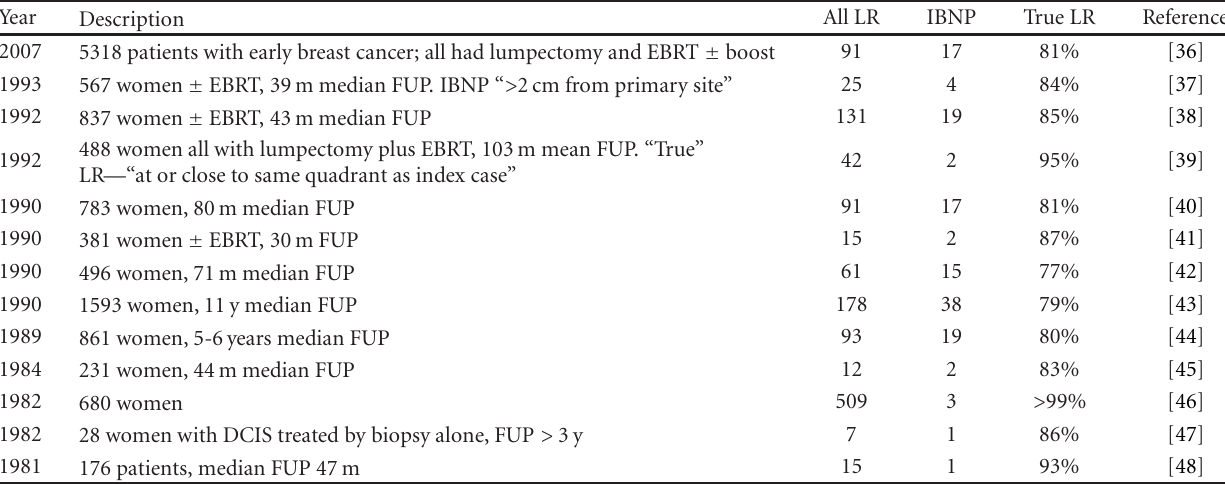
Table 1: Summary of evidence regarding the location of in-breast